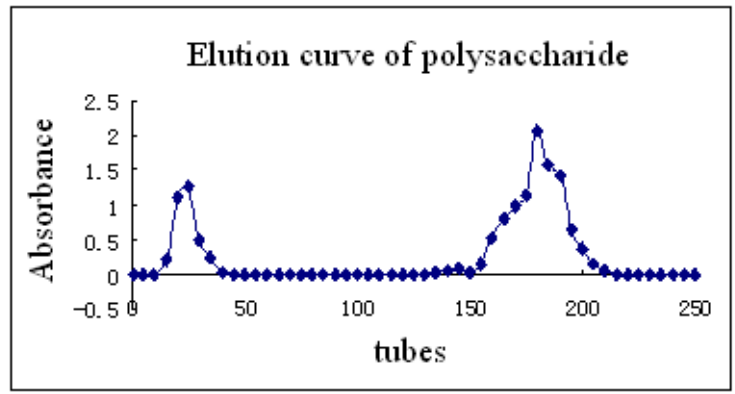
Figure 4. Absorbance by tube number.